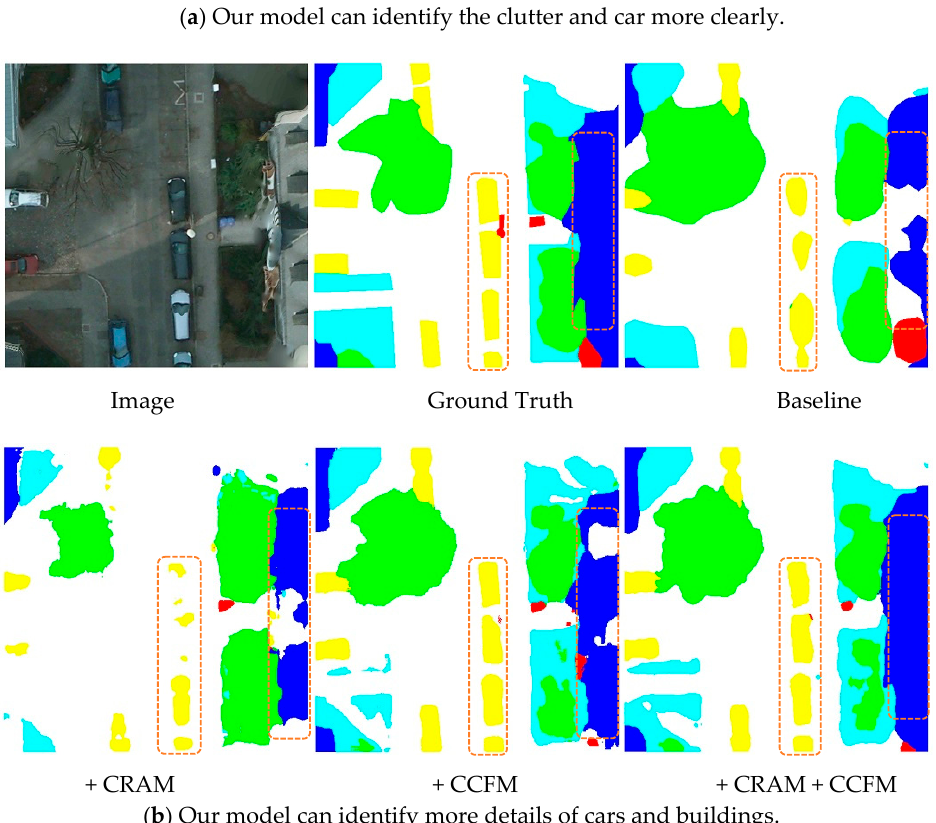
Figure 11. Visualization of the classification map generated by different